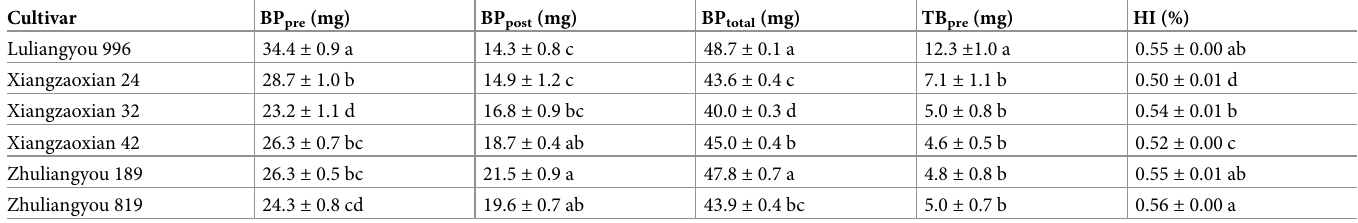
Table 3. Pre-heading biomass production per spikelet (BP pre ), post-heading biomass production per spikelet (BP post ), total biomass production per spikelet (BP total ), translocation of pre-heading biomass to each spikelet (TB pre ), and harvest index (HI) of six early-season rice cultivars.